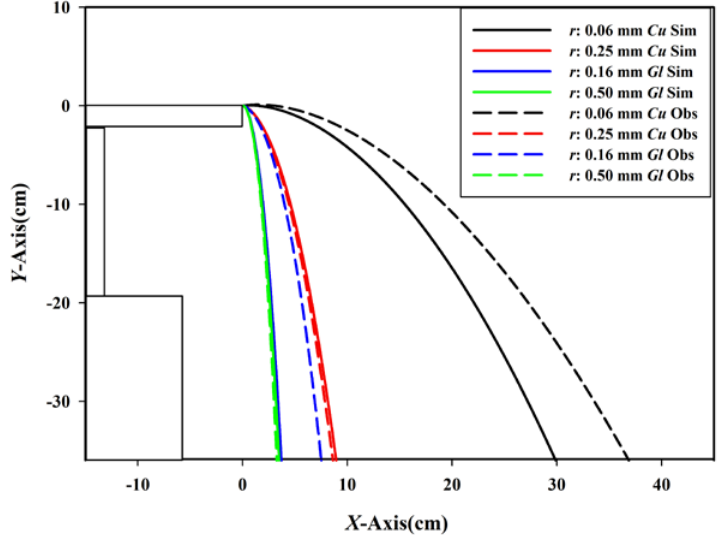
Figure 10. Observed (Obs) vs. simulated (Sim) trajectories of cylindrical copper (Cu) and spherical glass ( Gl ) pretreated by sieving/washing (applied voltage: 20 kV, relative humidity: 35%, distance between electrodes: 60 cm, initial speed: 0.13 m/s).